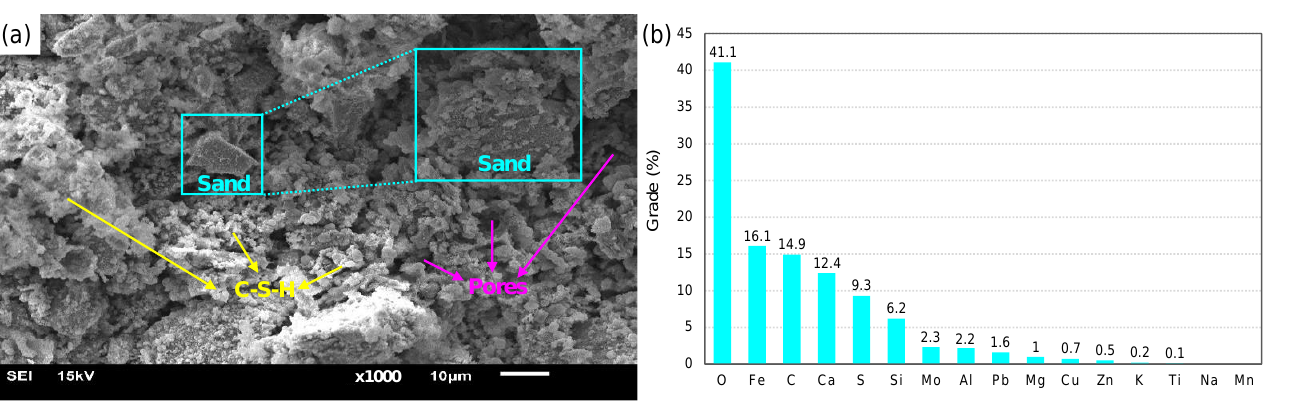
Figure 7. SEM ( a ) and EDS ( b ) results of 56-day cured CPB samples with 72 wt.% solid contents.